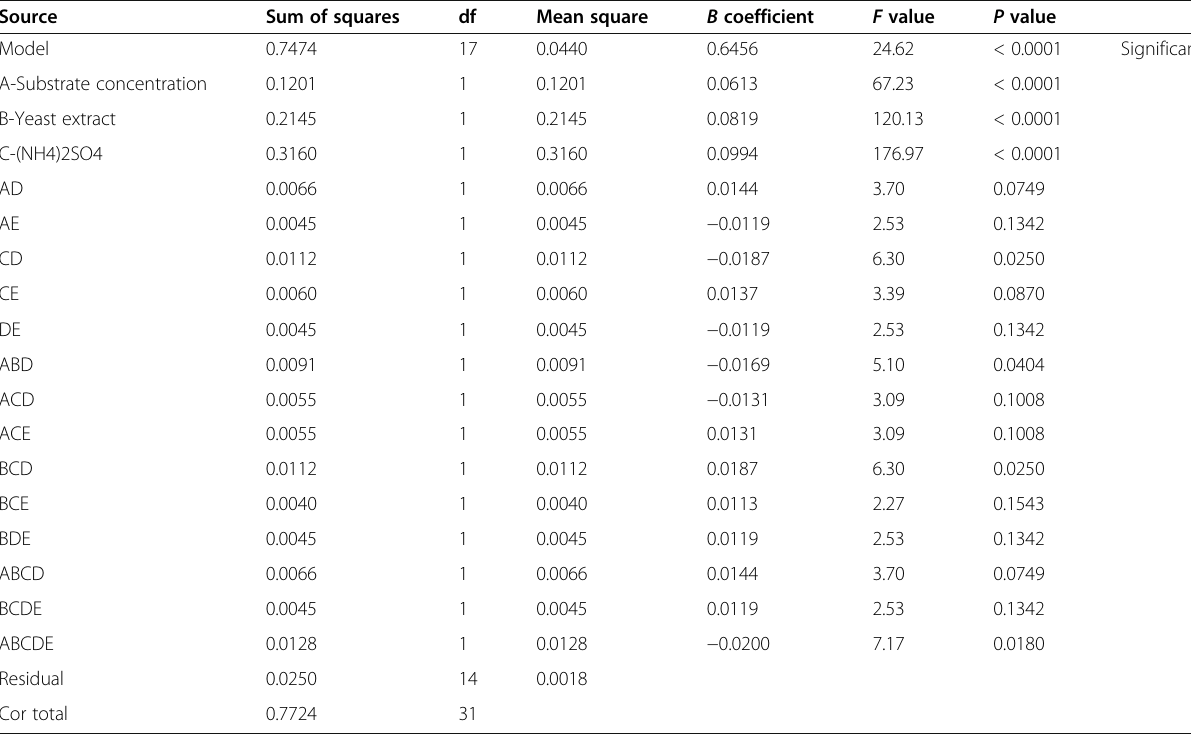
Table 3 Statistical analysis of variance (ANOVA) for the selected factorial design to optimization of xylanase production by Aspergillus